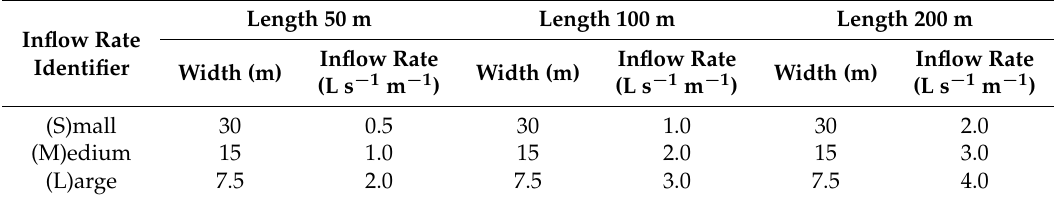
Table 7. Basin sizes and related unit inflow rates for modernized design alternatives.